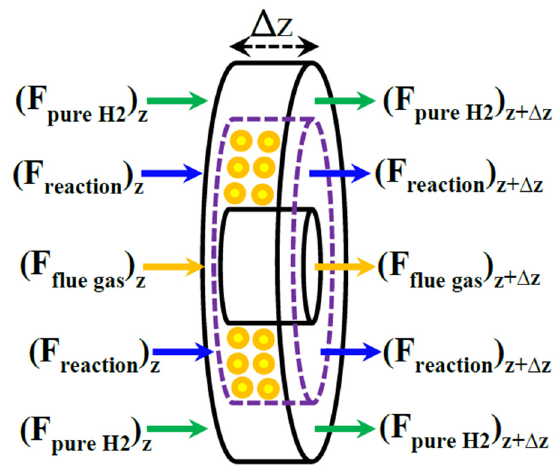
Figure 4. An elemental volume of the membrane reformer (MR) during MSR reaction process.